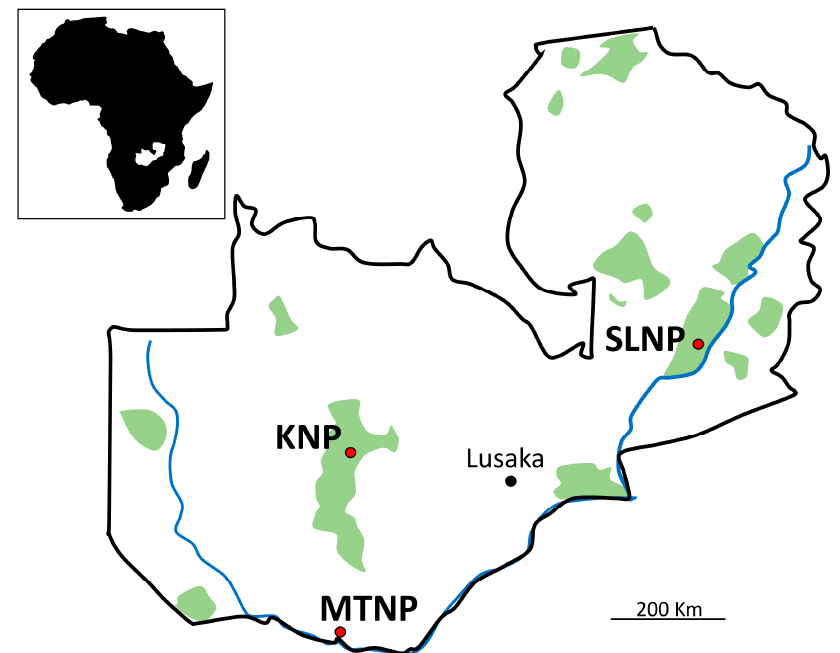
Figure 1. Map of sample collection sites. Capital city and sampling sites are displayed in black and red points. MTNP: Mosi-oa-Tunya National Park, KNP: Kafue National Park, SLNP: South Luangwa National Park.